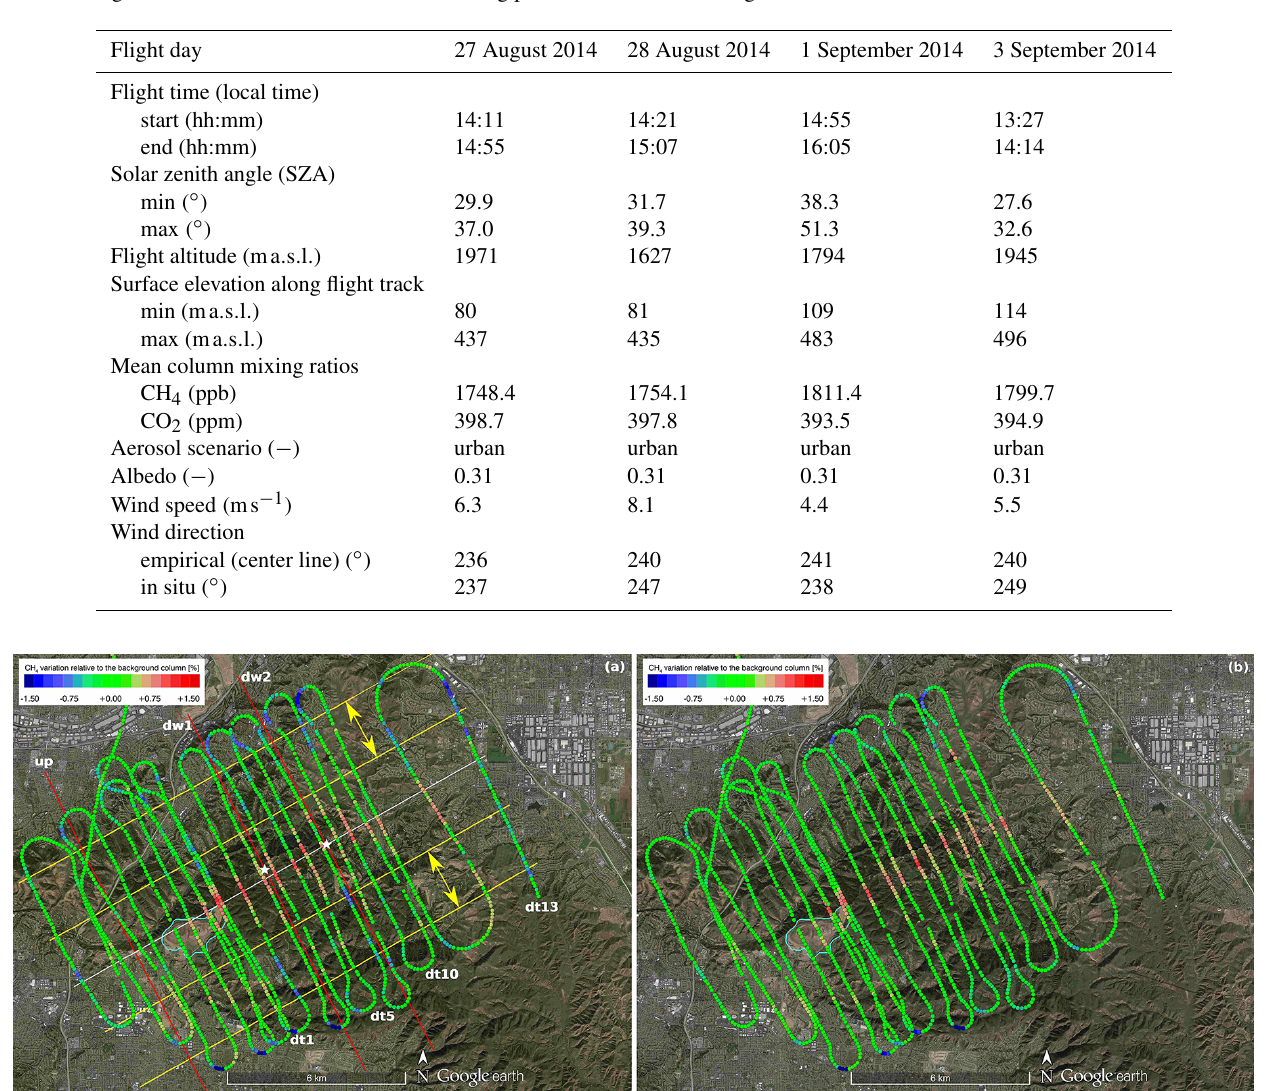
Table 1. Flight conditions and MAMAP remote sensing parameters for the four flights.